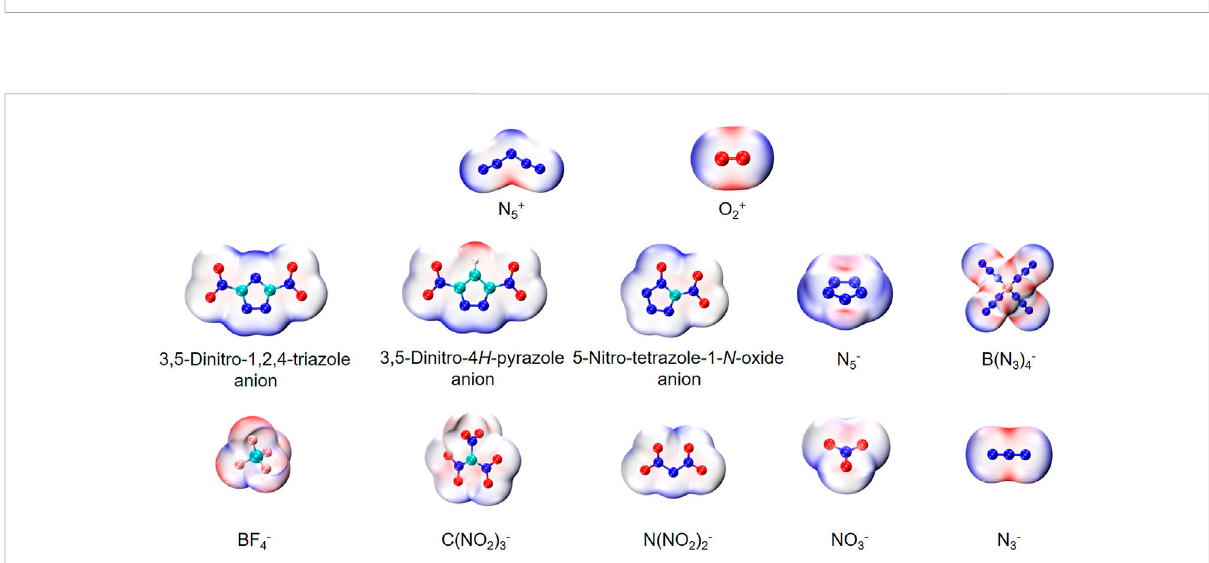
FIGURE 2 ThemolecularvanderWaalssurfaceelectrostaticpotentialdistributionofanionsandcations.Theredregionrepresentsthehigherelectrostatic potential in the molecular and blue region represents the lower electrostatic potential in